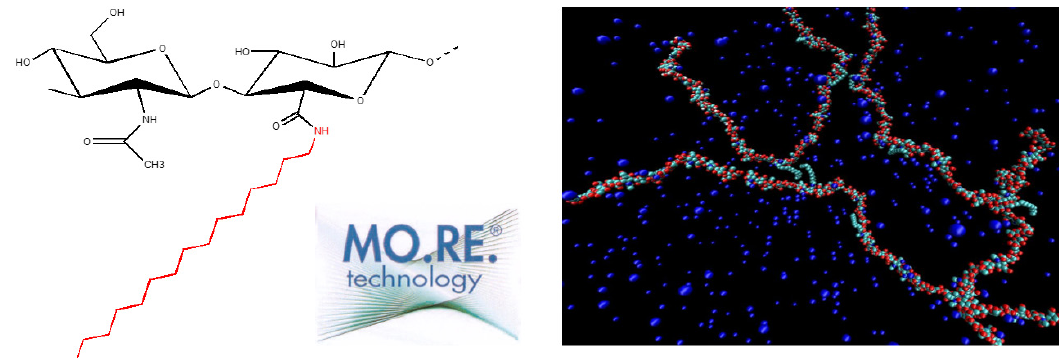
Figure 3. A network stabilized by reversible hydrophilic and hydrophobic interactions, conferring high viscoelasticity and stability to a medium molecular weight (MW) HA derivative.